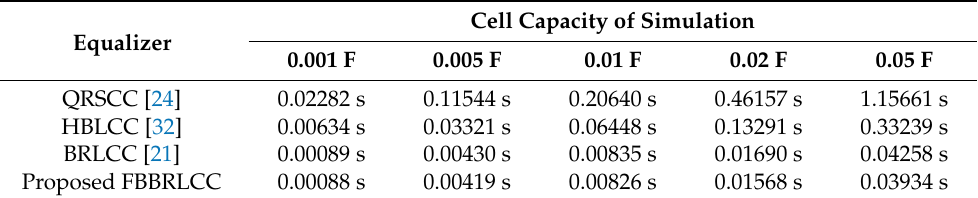
Table 2. Simulation comparison of the influence of different cell capacities on balancing time under the initial voltages #1.